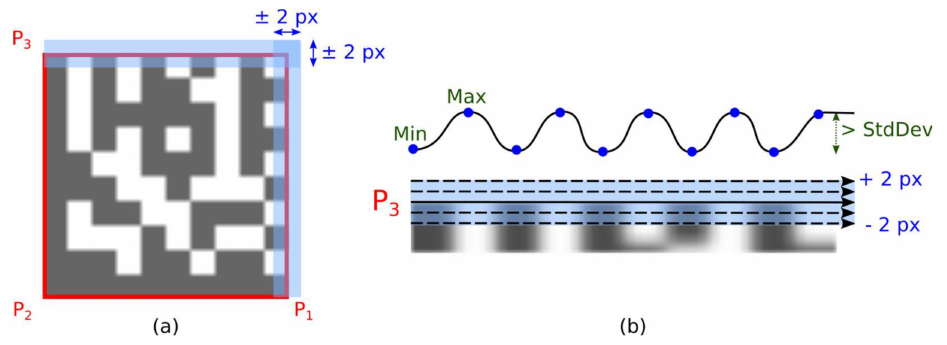
Figure 16. Local extremes in Timing Pattern areas. ( a ) Timing Pattern areas; ( b ) Local extremes. Timing Pattern areas (vertical and horizontal) are scanned line by line. For each line scan are